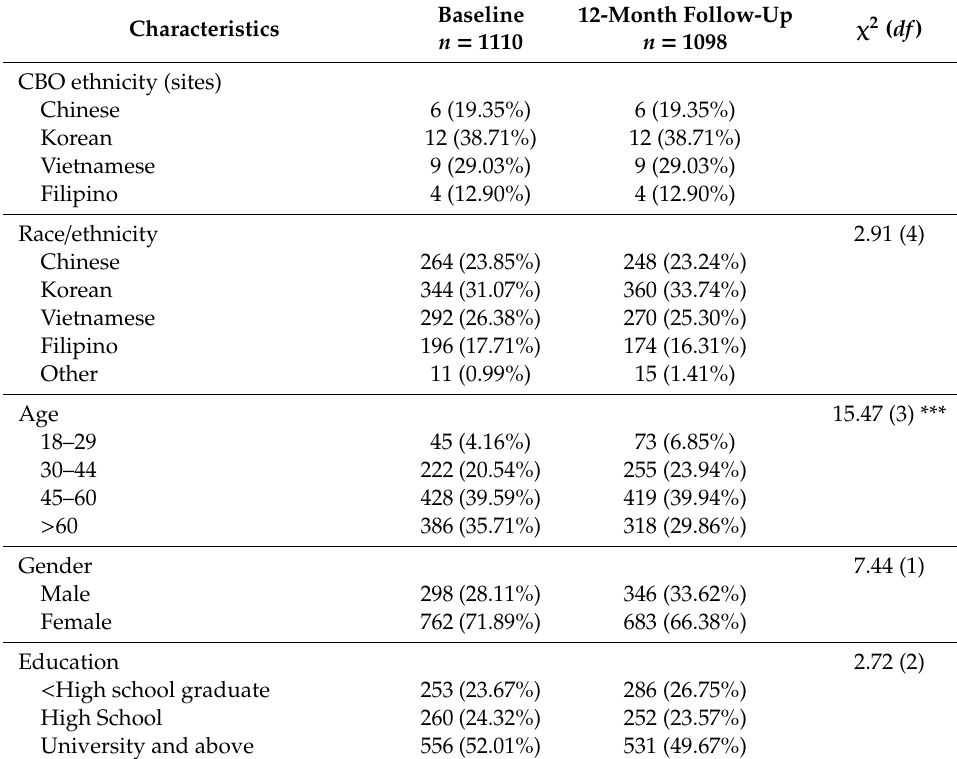
Table 1. Sociodemographic, Language, and Health-Related